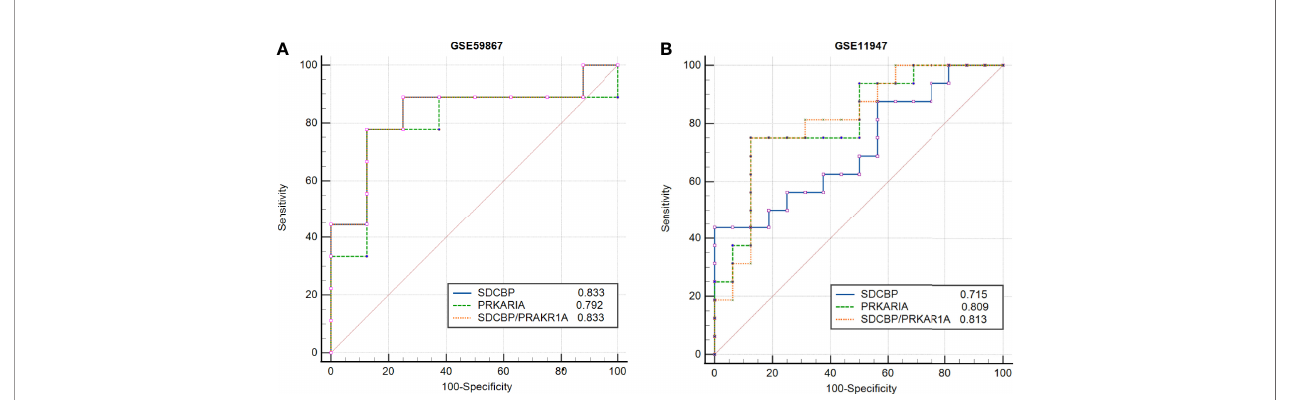
FIGURE 8 | Receiver operating characteristic (ROC) curve analysis of potential biomarkers. ROC curves of PRKAR1A, SDCBP, and the combination of SDCBP/ PRKAR1A, and the areas under the ROC curves were presented based on the expression levels of GSE59867 (A) and GSE11947 (B) datasets,